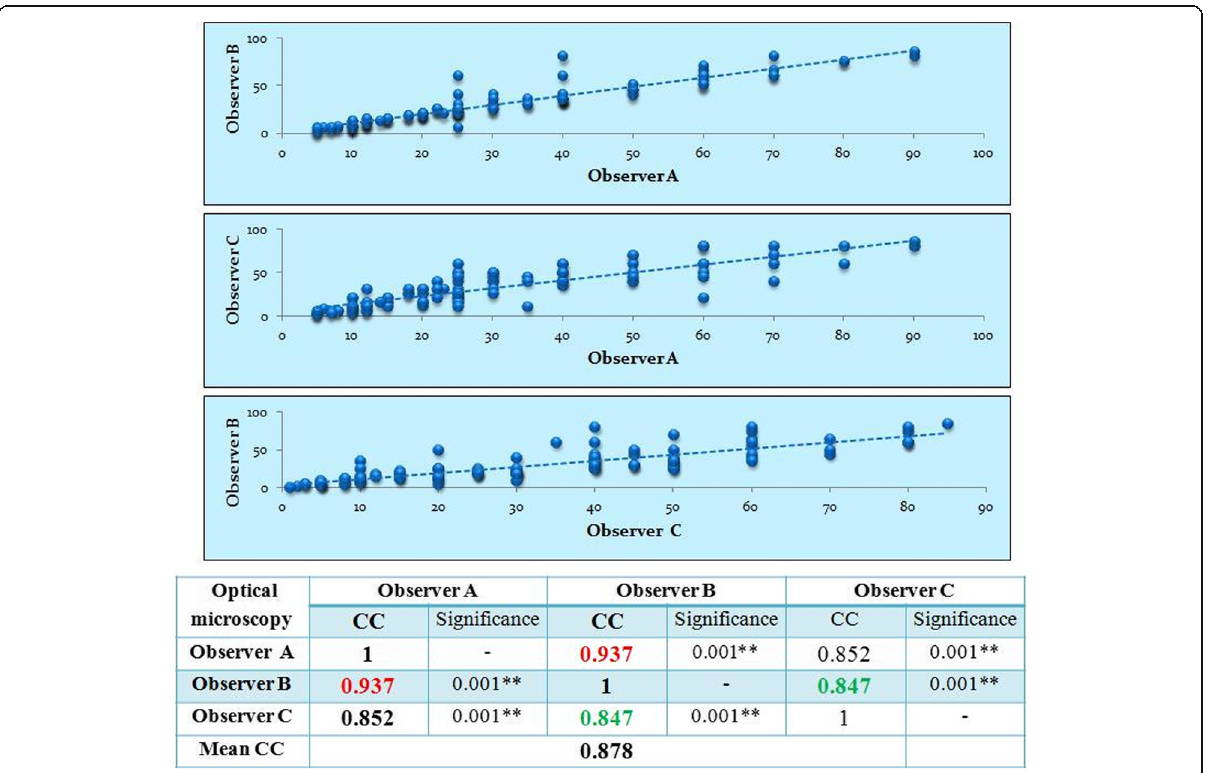
Fig. 1 Inter-observer variability on optical microscopy using continuous